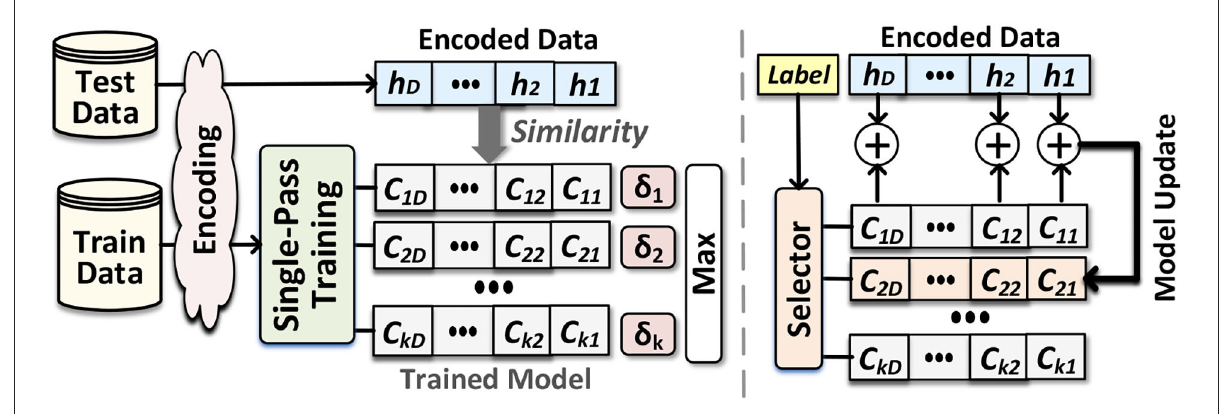
FIGURE3 Hyperdimensional classification: Overview of EventHD for training and inference (left) and the routine for single-pass training (right) .